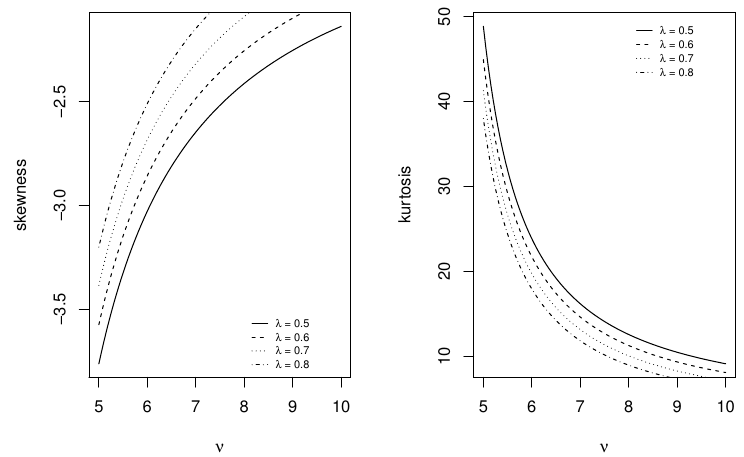
Figure 8. Skewness and kurtosis plots of the LiPa1 distribution as a function of parameter ν .